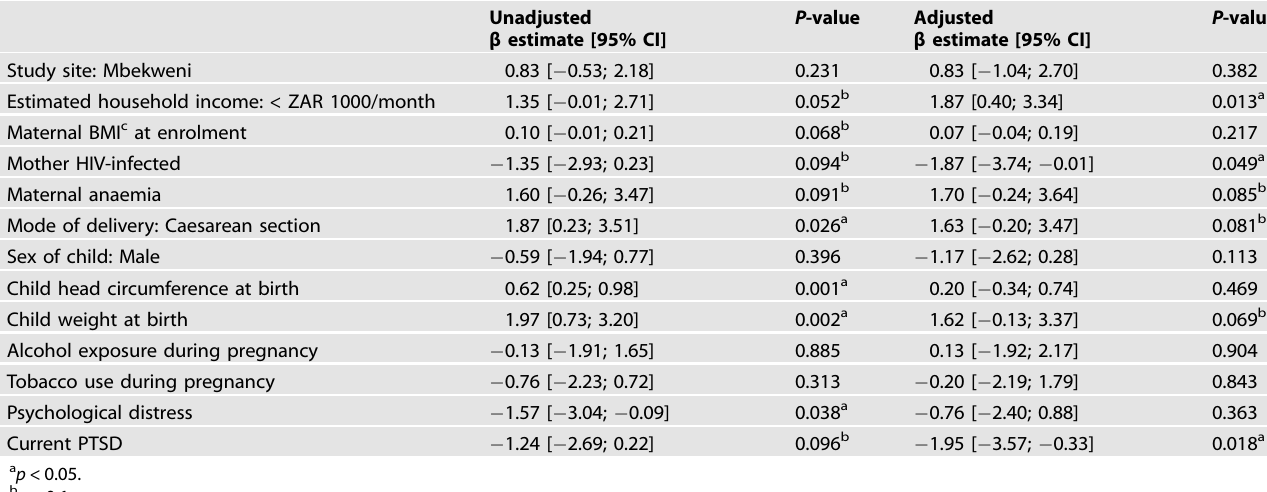
Table 3. Associations between maternal psychosocial risk factors and gestational epigenetic age deviation at